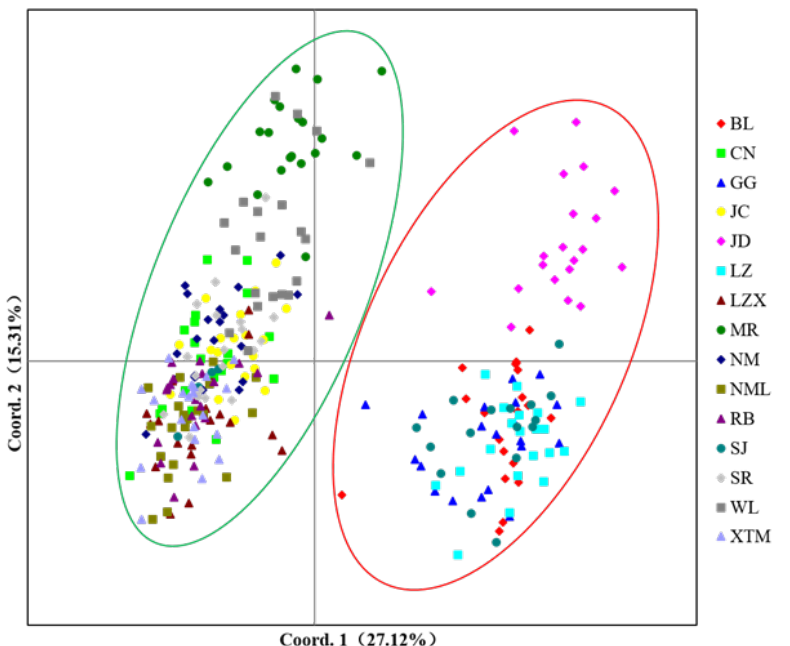
Figure 3. Principal component analysis based on the SSR data of 300 S. moorcroftiana individuals.